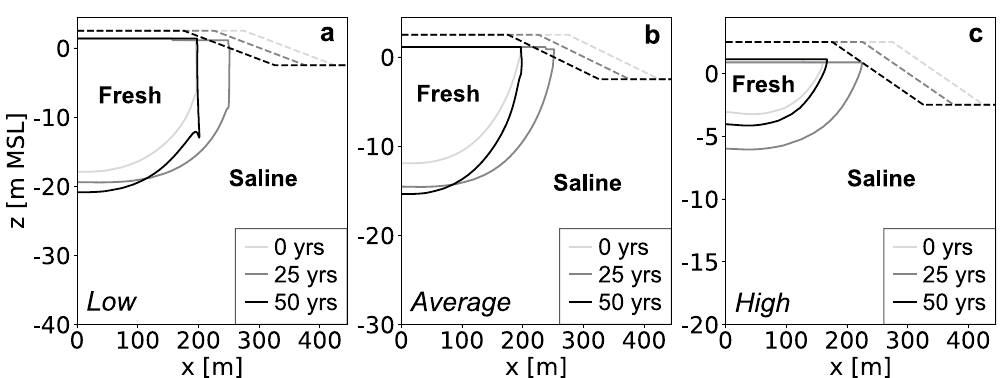
Figure 3. Simulated growth of the fresh groundwater lens for low (left), average (centre), and high (right) estimates of the hydraulic conductivity in sandy shores. All images contain the fresh-salt groundwater interface of 1 g TDS L − 1 (solid lines) and the surface elevation (dashed lines) at the start (light grey), middle (dark grey) and end (black) of the simulation